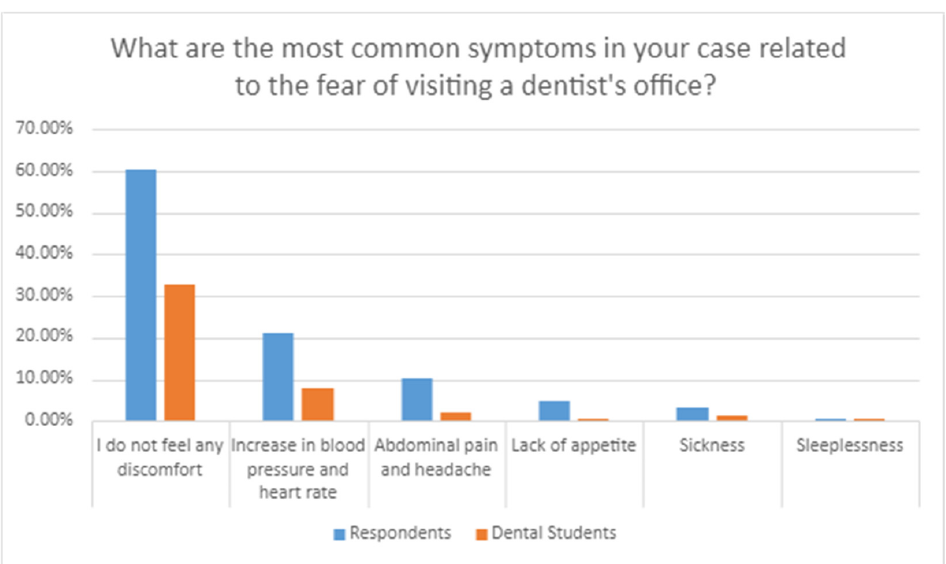
Figure 1. Types of symptoms appearing in a patient before visiting the office.